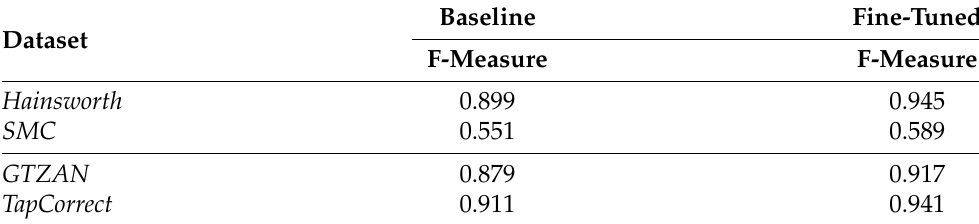
Table 2. Mean F-measure scores across datasets for the baseline and fine-tuning